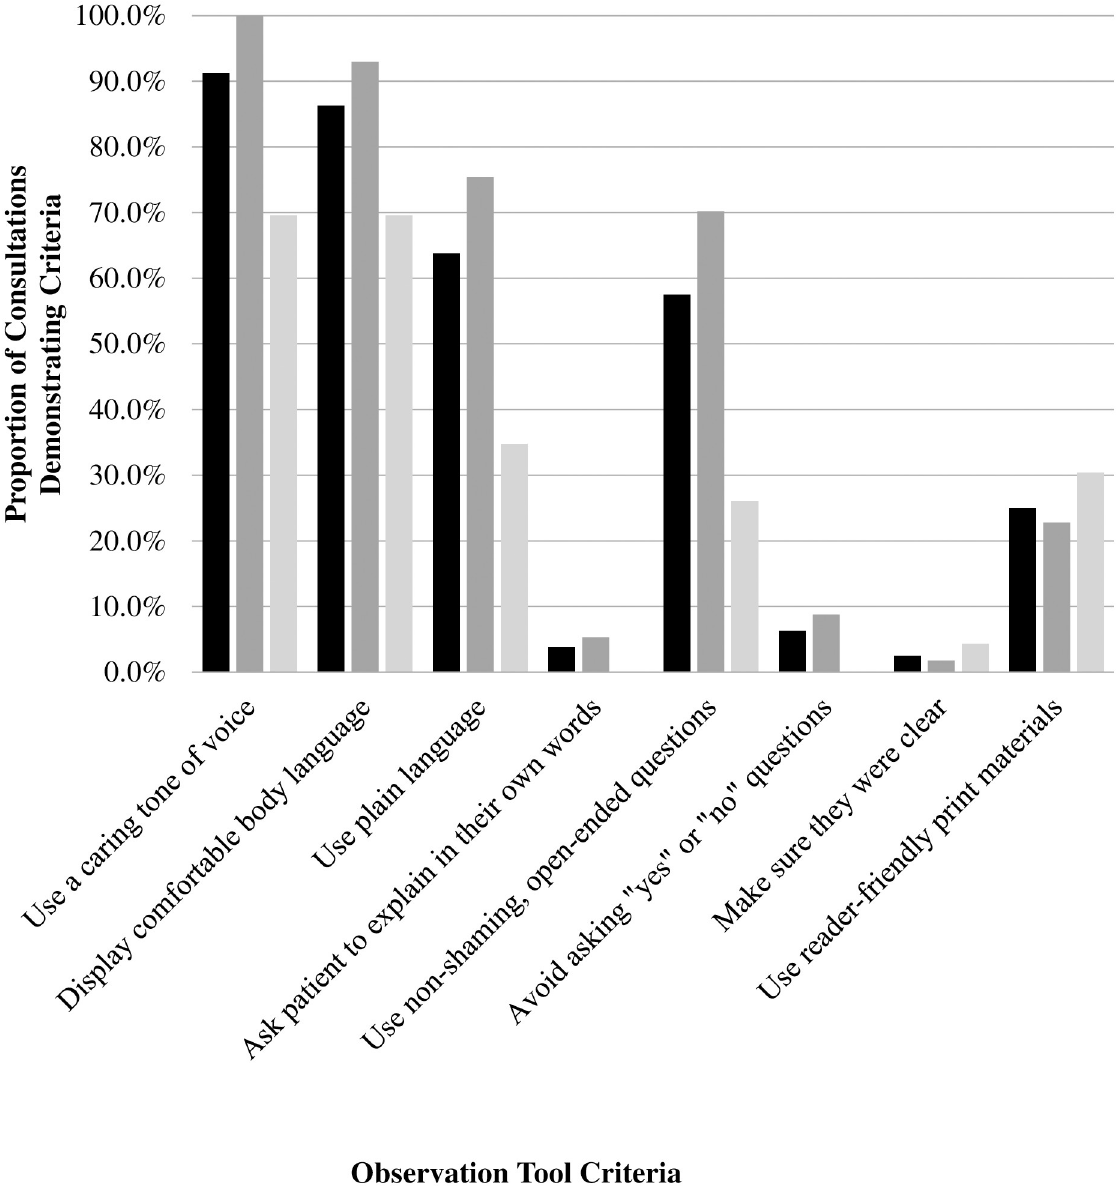
Fig 1. Proportion of consultations where physicians used health literacy universal precautions to communicate with patients in aggregate format and stratified by areas of deprivation. � Black bars represent the proportion of aggregate consultations demonstrating criteria (N = 80). † Dark gray bars represent the proporition of consultations demonstrating criteria in low deprivation areas (n = 57). ‡ Light gray bars represent the proporition of consultations demonstrating criteria in high deprivation areas (n = 23). § Criteria adapted from Observation Tool (Asan & Montague, 2014). k The following Observation Tool criteria were excluded from the graph because they did not apply to the majority of consultations: 1) explain and check again if the patient is unable to teach-back; 2) document the patient’s teach-back response; and 3) include present family members or